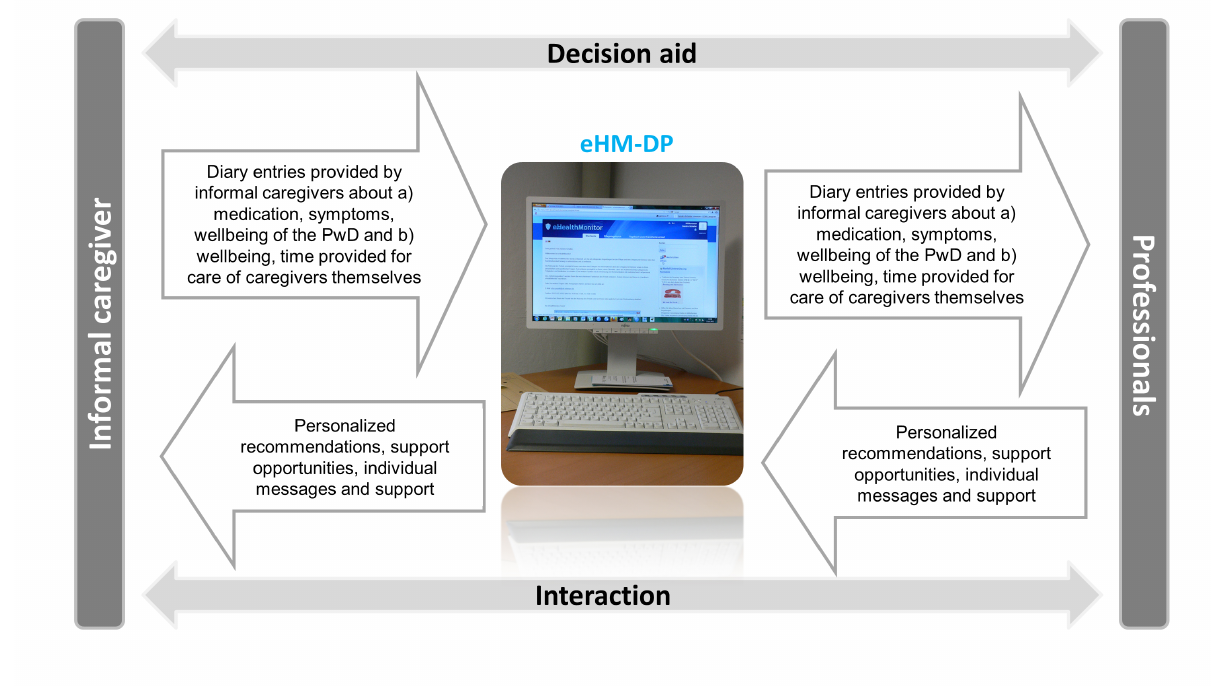
Figure 1. Schematic representation of the